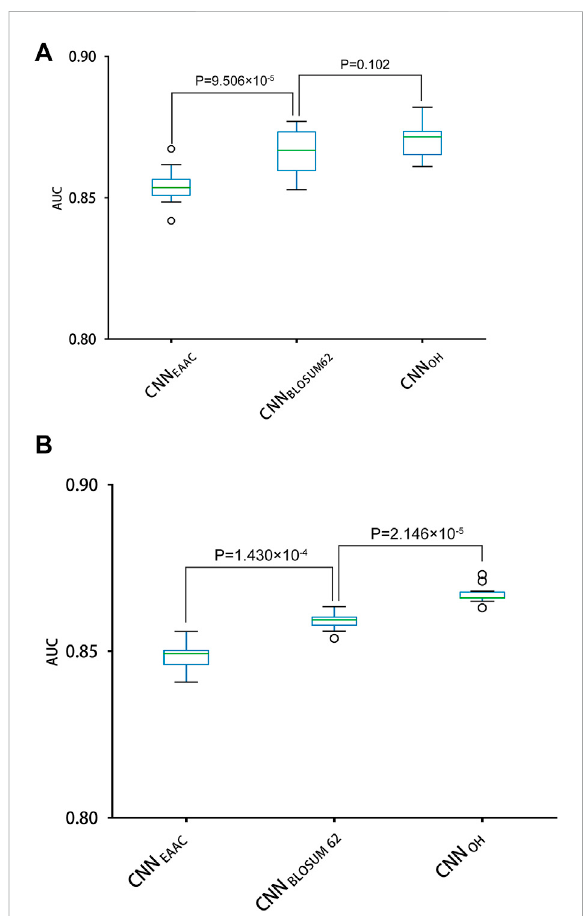
FIGURE 4 Performances of the CNN models with different features for predicting PRme sites. (A) The AUC values of different models using ten-fold cross-validation. (B) The AUC values of different models in the independent test.